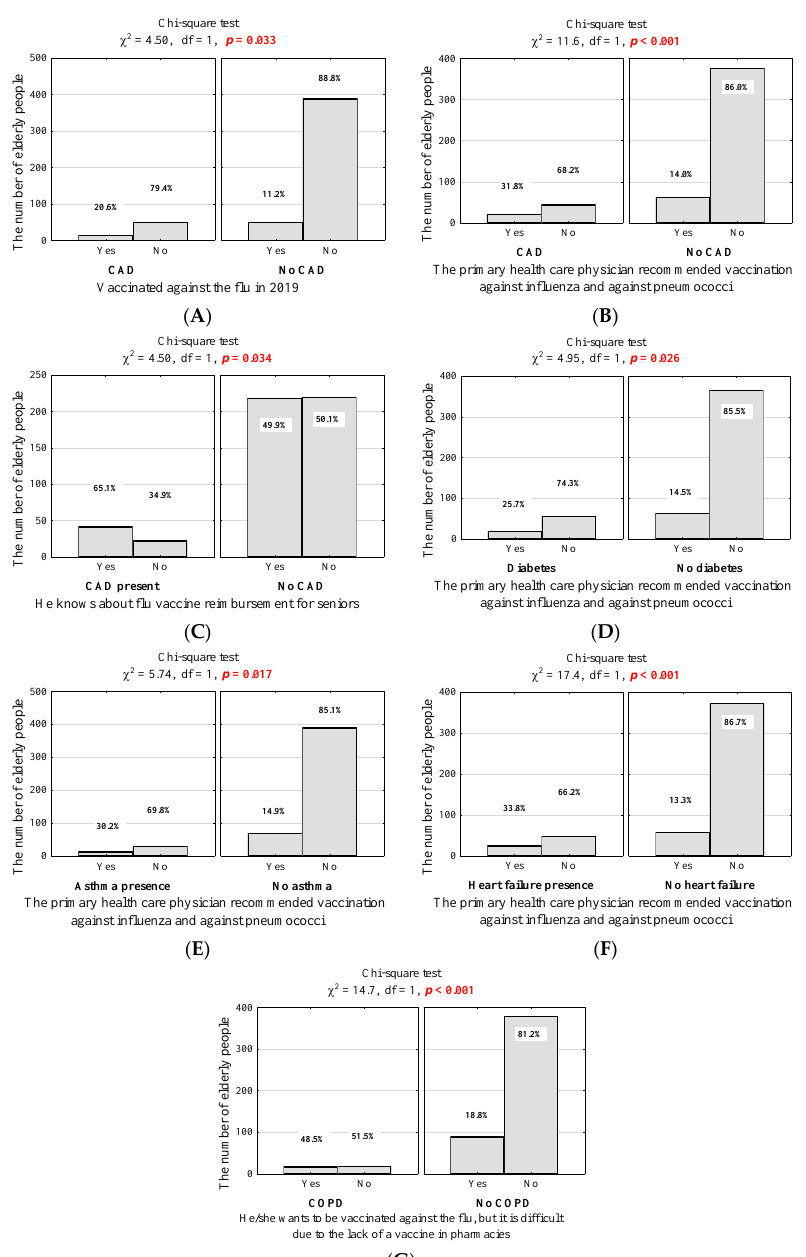
Figure 3. ( A ) Number (percentage) of people in groups that differed in 2019 influenza vaccination and coexistence of coronary artery disease; ( B ) The number (percentage) of people in the groups differing in the coexistence of coronary artery disease and the recommendation of a primary healthcare physician to vaccinate against influenza and pneumococci; ( C ) Number (percentage) of people in groups that differ in the coexistence of coronary artery disease and know about the reimbursement of influenza vaccine for seniors; ( D ) Number (percentage) of people in groups differing in the coexistence of diabetes and the recommendation of a primary healthcare physician to vaccinate against influenza and pneumococci; ( E ) The number (percentage) of people in the groups differing in the coexistence of asthma and the recommendation of a primary healthcare physician to vaccinate against influenza and pneumococci; ( F ) The number (percentage) of people in the groups differing in the coexistence of heart failure and the recommendation of a primary healthcare physician to vaccinate against influenza and pneumococci; ( G ) Number (percentage) of people in the groups differing in their responses to the question about the willingness to be vaccinated against influenza and the coexistence of COPD and the results of the independence